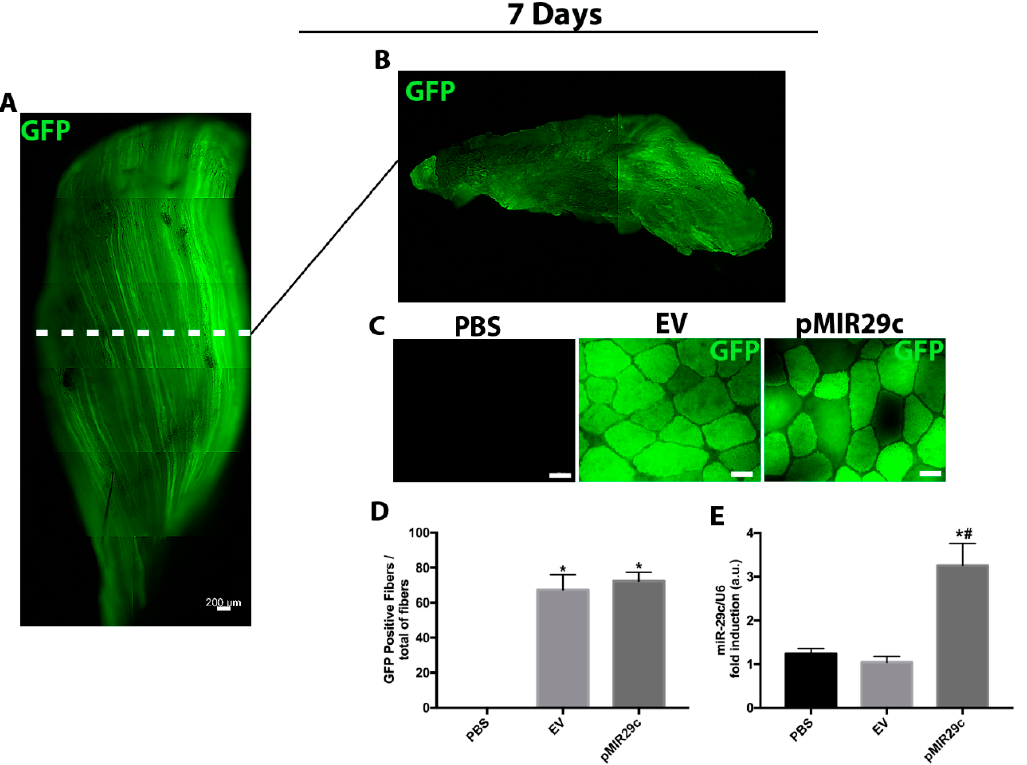
Figure 1. Plasmid transfection efficiency and levels of miR-29c in skeletal muscle. ( A ) Representative photograph composition of tibialis anterior and ( B ) the correspondent transversal section (GFP in green). ( C ) Representative photomicrograph of tibialis anterior muscle cross-section at 7 days of miR-29c overexpression showing positive (green) fibers. ( D ) Efficiency of transfection of the EV and miR-29c expression plasmid 7 days after electrotransfer. ( E ) RNA levels of miR-29c were determined by qPCR in muscles 7 days after electrotransfer. Data were expressed as a percentage of total fibers and arbitrary units (au) as mean and SEM ( n = 4–5 per group) and were corrected by the endogenous U6 RNA. Statistical analysis included one-way ANOVA followed by Tukey’s posthoc test and the Kruskal–Wallis test followed by Dunn’s posthoc test. * p < 0.05 vs. PBS and # p < 0.05 vs. EV